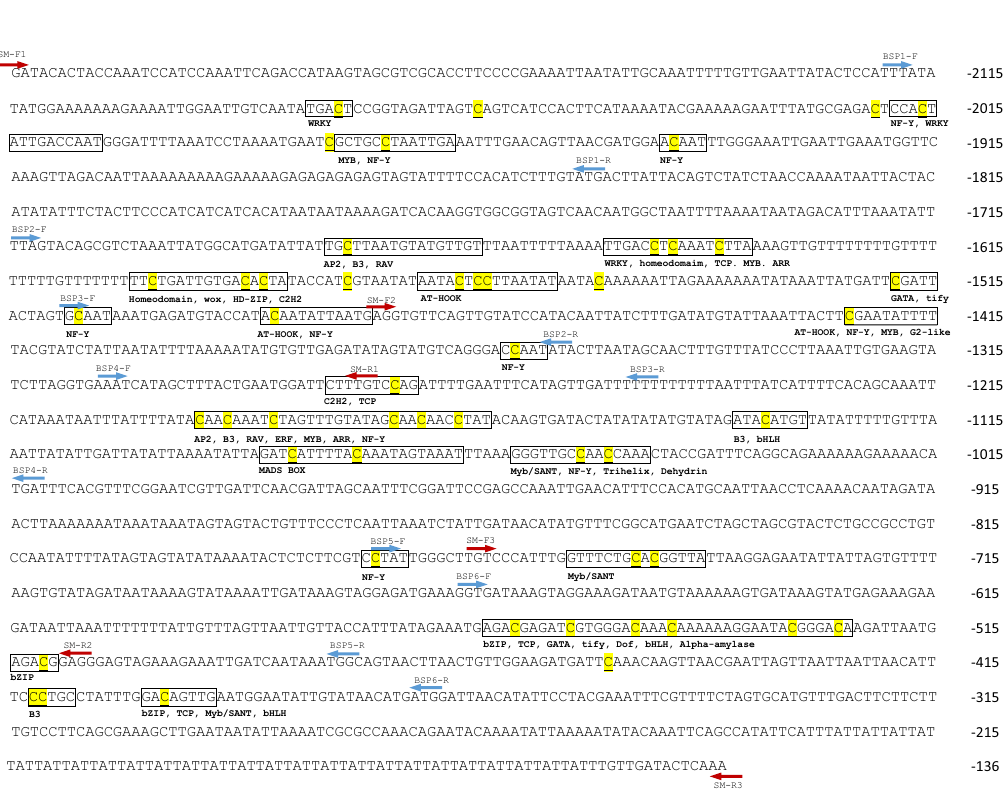
Figure 6. The S. miltiorrhiza CPS promoter region was amplified based on the reference from Szymczyk et al. Only the + strand is provided, and the specific primers are underlined. Compared with the control group, the demethylated cytosines are underlined in yellow, and the positions of putative transcription factors binding sites are boxed and indicated